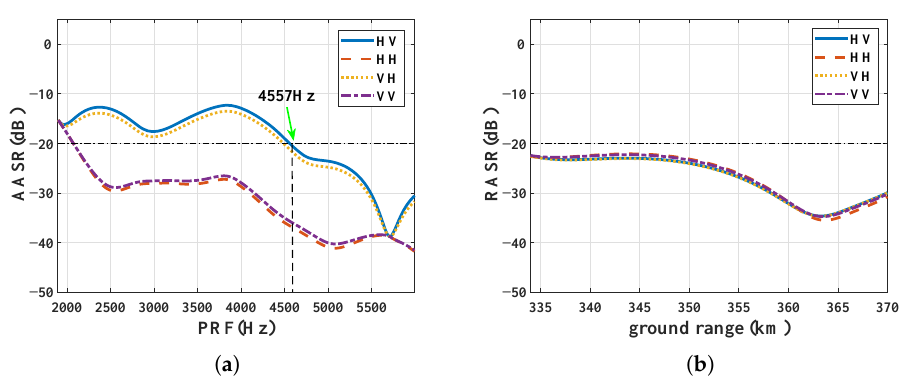
Figure 10. AASR and RASR performance of system #3 by JOSA method. ( a ) the AASR versus PRF. ( b ) the RASR (PRF = 3756 Hz) versus the ground